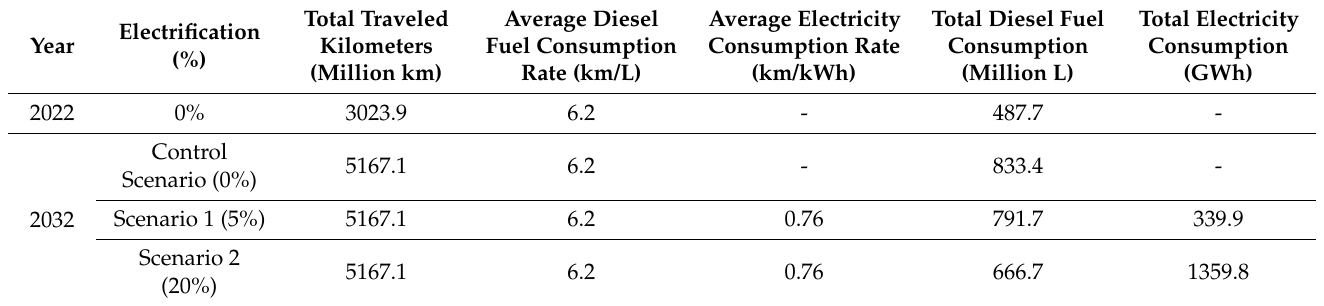
Table 2. Expected total fuel and electricity consumption by freight transport sector in Westbank, Palestine.